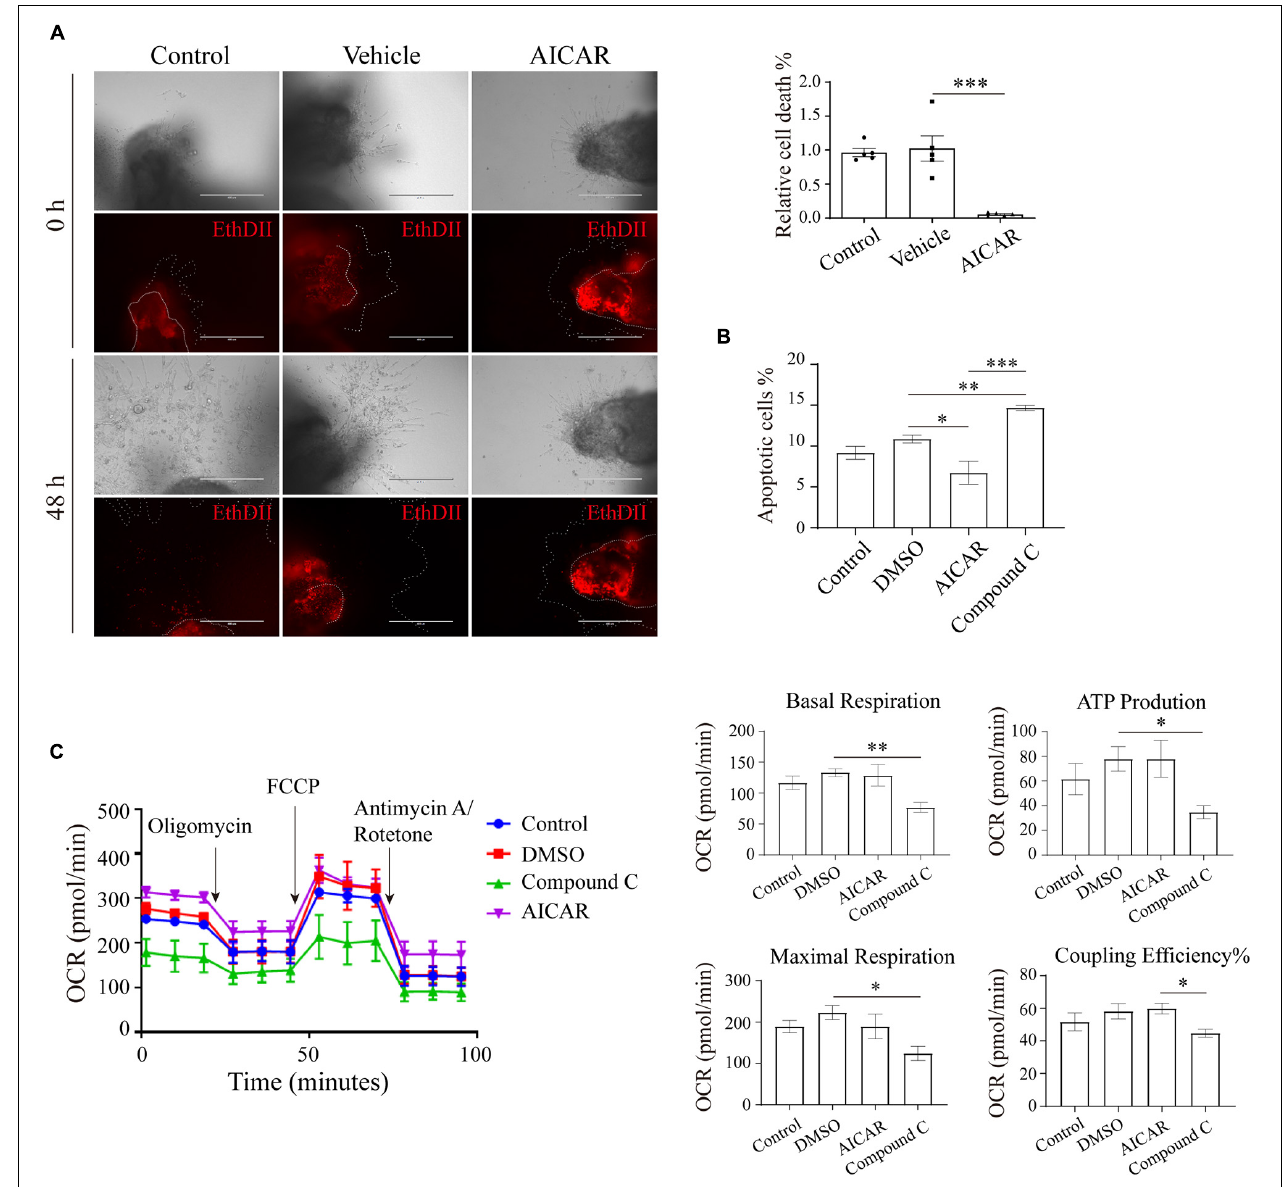
FIGURE 4 | AMP-activated protein kinase regulates viability in an in vitro trophoblastic GDM model. (A) EthD II-based detection of cell death in villous explants treated with 200 µ M AICAR for 48 h. Bar: 400 µ M; n = 5–27/group. (B) The apoptosis of HTR8/SVneo cells after 24 h of incubation with 200 µ M AICAR or 10 µ M compound C was measured by flow cytometry ( n = 3); 0.1% DMSO served as the vehicle. (C) Oxygen consumption rate (OCR) of HTR8/SVneo cells treated with 200 µ M AICAR or 10 µ M compound C for 24 h ( n = 3). The data that are presented as the means ± SEMs are annotated in normal font, and ordinary ANOVA test was used among multiple groups. The data presented as the medians (IQRs) are shown in bold font, and Kruskal-Wallis test was used among multiple groups. ∗ p < 0.05, ∗∗ p < 0.01, and ∗∗∗ p <